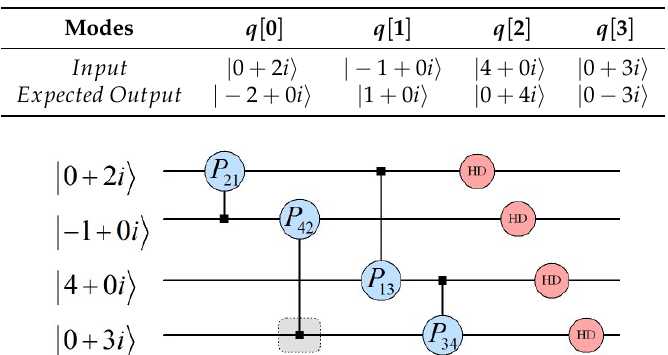
Table 4. Experimental results with the the key-length n = 4, K final = { 2,4,1,3 } . “Modes” represent